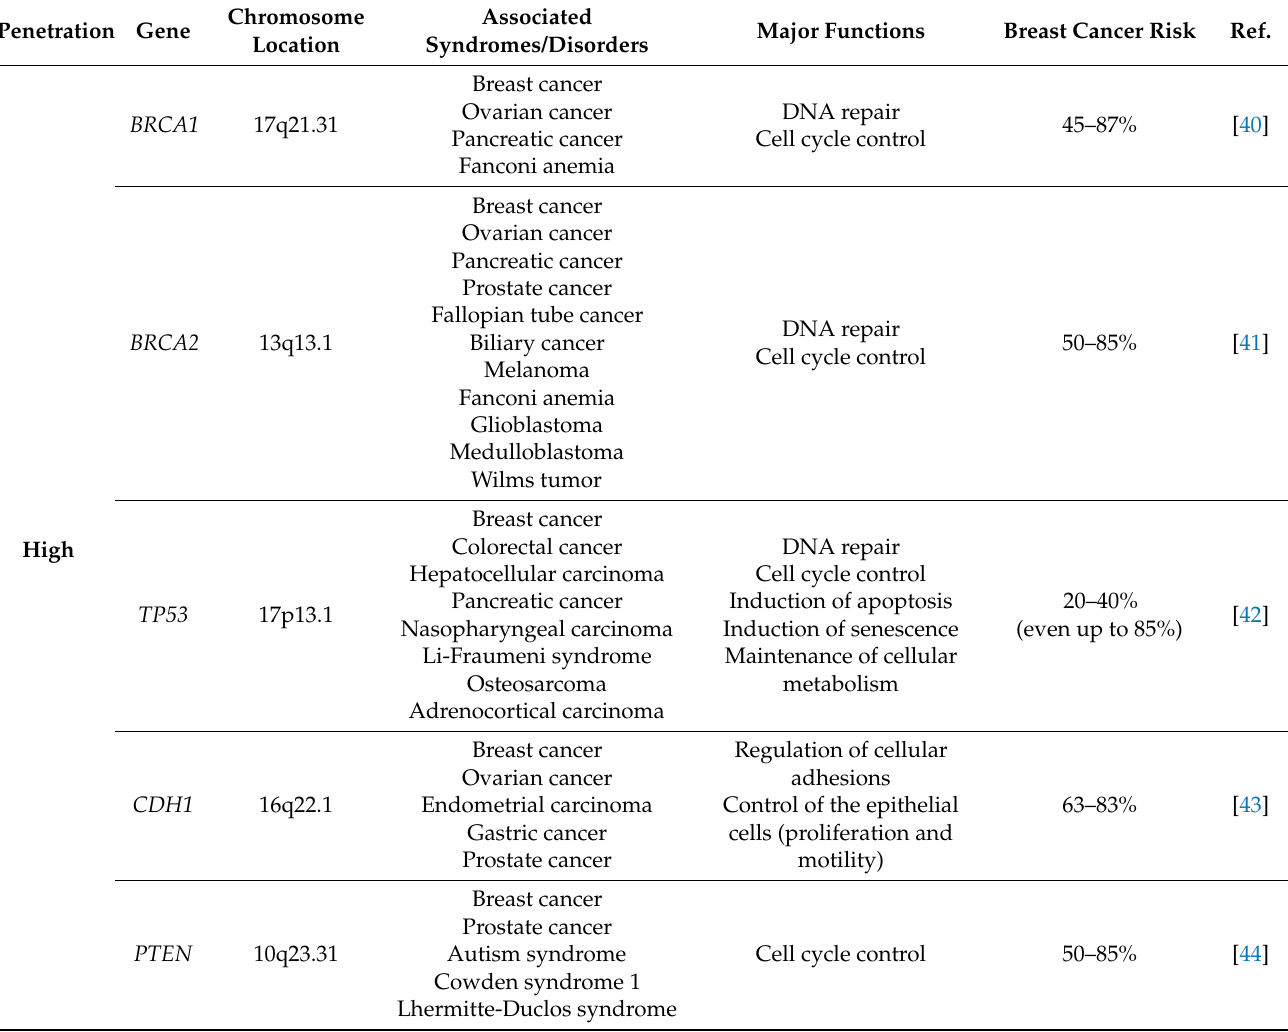
Table 2. Major genes associated with an increased risk of breast cancer